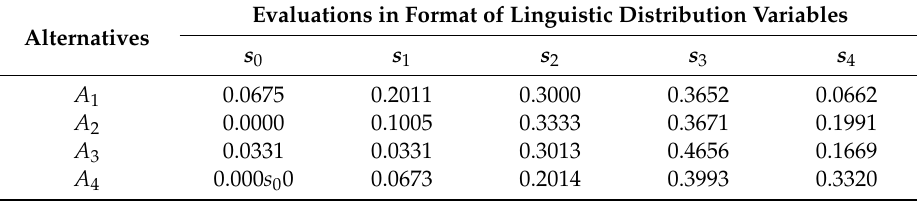
Table 1. The linguistic distribution evaluations on criterion C 1 .